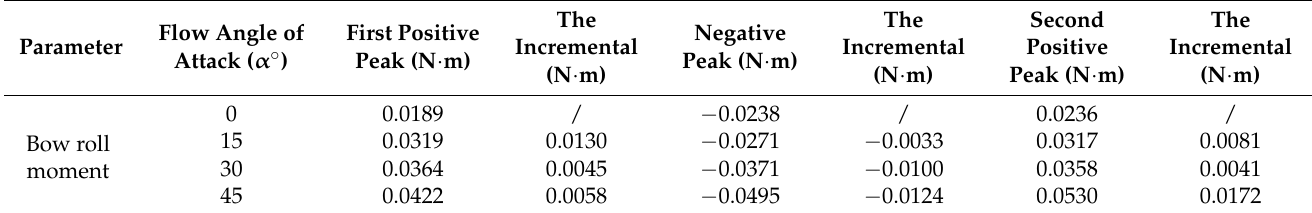
Table 3. Statistical table of bow roll moment peaks.